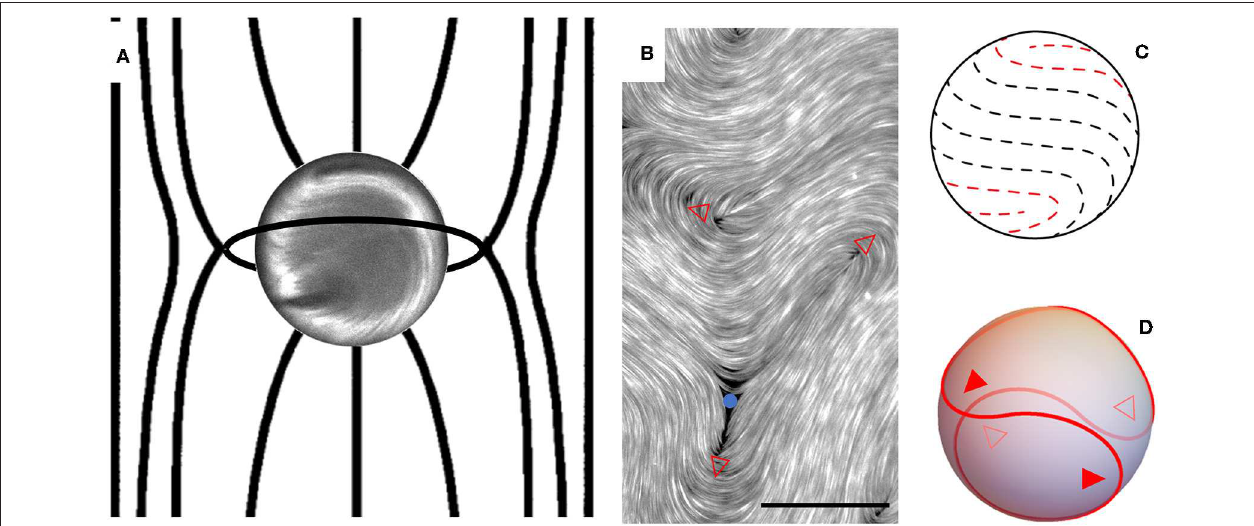
FIGURE 1 | (A) Sketch of the nematic director field lines around a dispersed droplet of aqueous based active material that imposes homeotropic anchoring conditions. The NLC has a homogeneous far field oriented in the vertical direction in this sketch. The confining plates are parallel to the plane of the sketch. The droplet, which is visualized with fluorescence microscopy, has a diameter of 80 µ m. The homeotropic anchoring conditions on the droplet surface lead to the formation of a line disclination that wraps around the equator. (B) Structure of an Active Nematic layer forming at a flat water/oil interface, with the core of some positive (red empty triangles) and negative (blue full circles) semi-integer defects being marked. The ruler is 20 µ m long. (C) Approximate director field lines of the Active Nematic shell observed in the droplet of (A) . In red, the core of the two visible +1/2 defects is sketched. (D) Theoretical rendering of the four +1/2 defects that organize the flows in active shells present in droplets of this size. Solid triangles correspond to visible defects while empty triangles correspond to hidden defects.